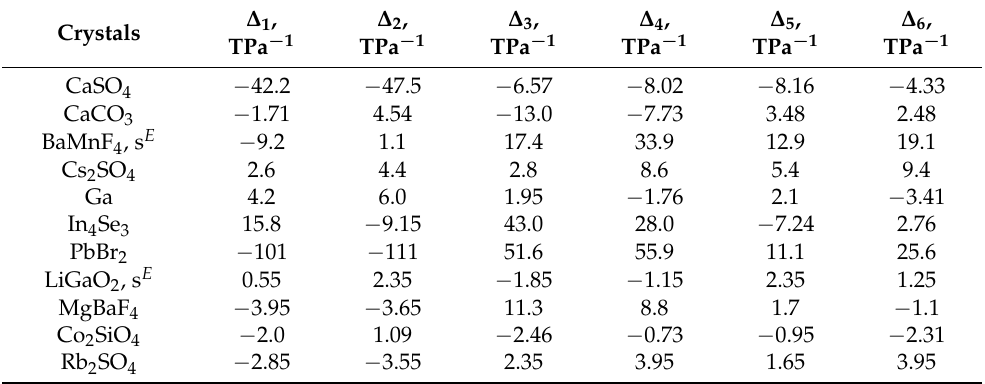
Table 1. Values of anisotropy coefficients ∆ 1 , ∆ 2 , ∆ 3 , ∆ 4 , ∆ 5 and ∆ 6 of some rhombic crystals.